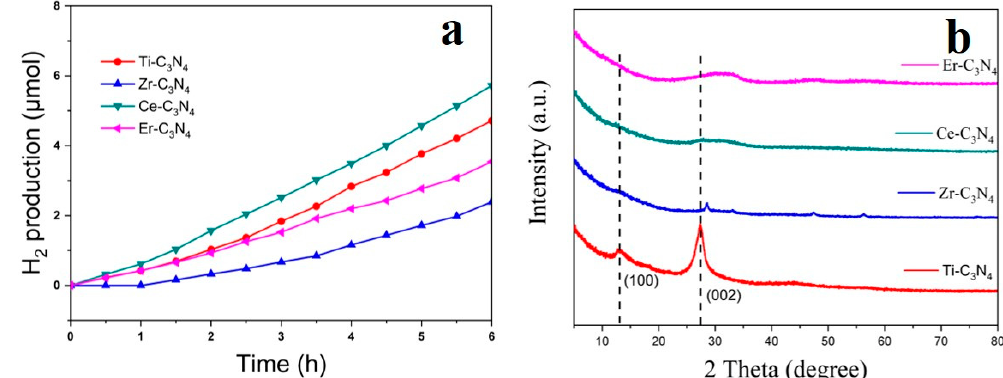
Figure 2. ( a ) Photocatalytic H 2 evolution of M-C 3 N 4 (M = Ti 4+ , Zr 4+ , Ce 3+ , or Er 3+ ). ( b ) X-ray diffraction (XRD) patterns for M-C 3 N 4 (M = Ti 4+ , Zr 4+ , Ce 3+ , or Er 3+ ).